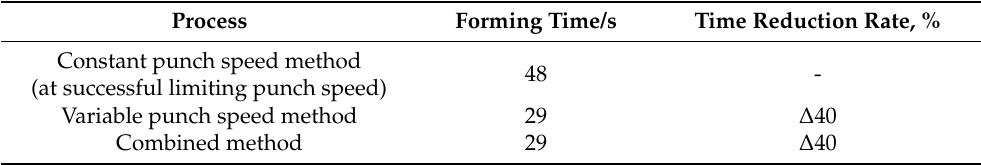
Figure 14. Comparison of thickness distributions of drawn cup for different processing paths (DR = 3.1). ( a ) Thickness distribution, ( b ) variable punch speed (VSPD) path and the same VBHF path as Figure 14b. Table 2. Forming time for different variable processing methods (DR = 3.1, punch stroke = 80 mm).